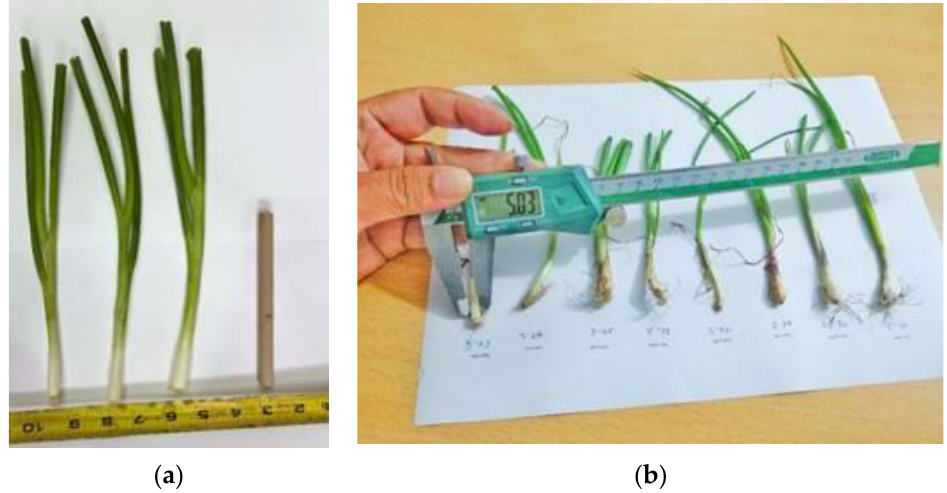
Figure 12. ( a ) Scallions next toa 0.95 cm (3/8 ″ ) dowel; ( b ) Bangladeshi onion seedlings. A profile of the scallions was created by taking various length and width measure- ments, which can be seen in Figure 13.